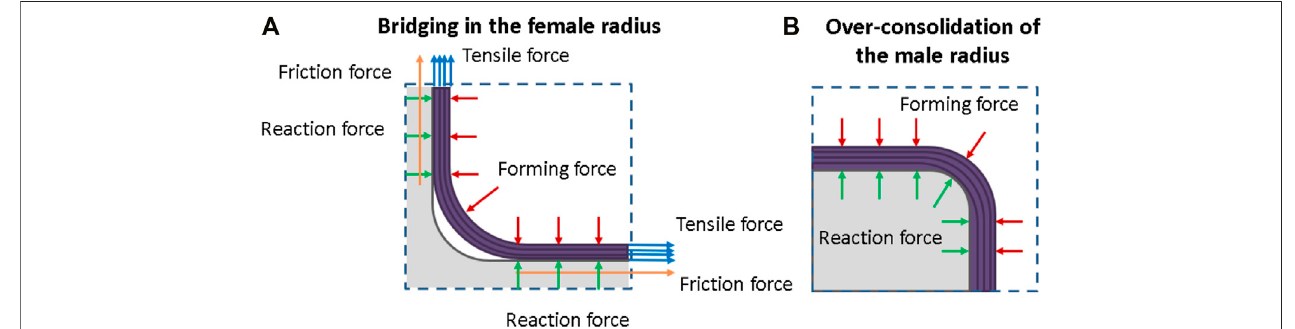
FIGURE 2 | Force schematic for a female radius (A) and a male radius (B) in a single diaphragm forming set